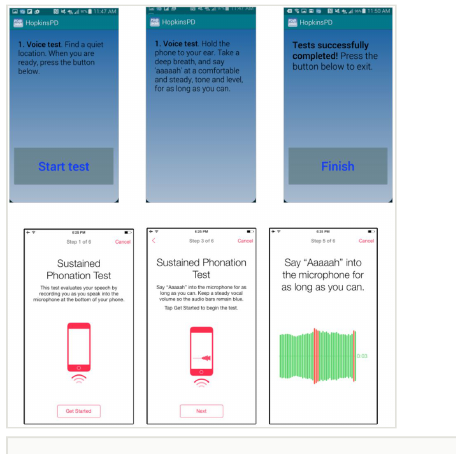
Figure 6. Android and iOS Parkinson app